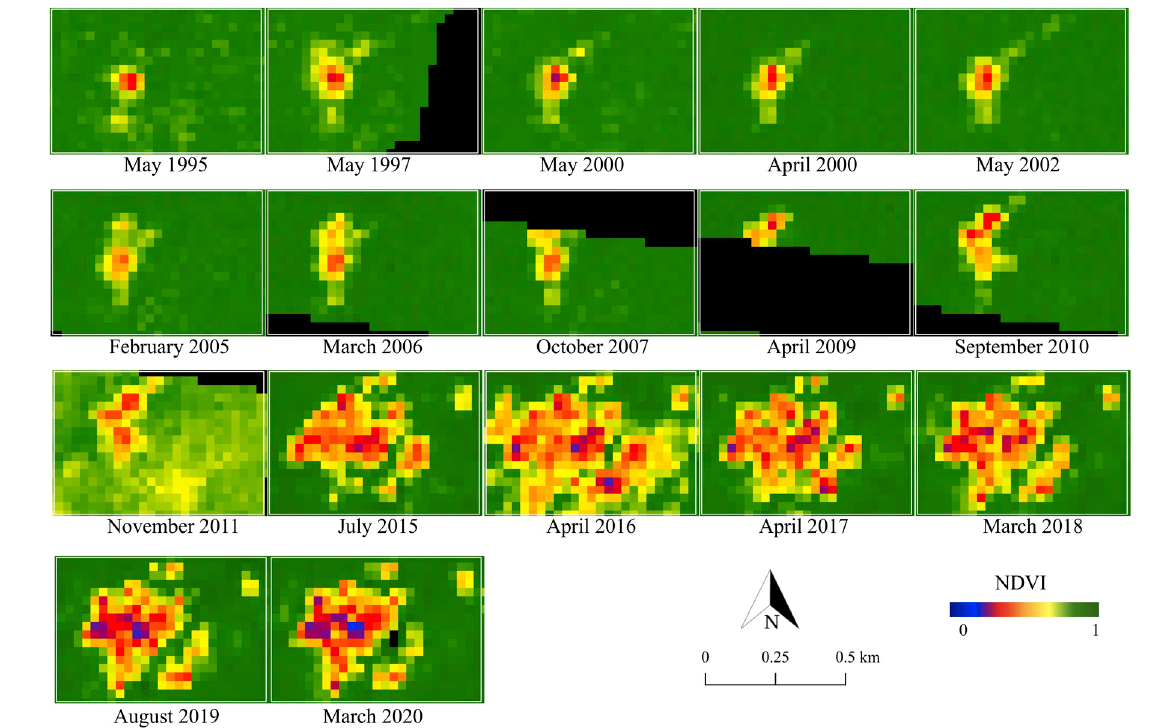
Figure 4. Changes in NDVI in Motomboto ASGM camp 2.